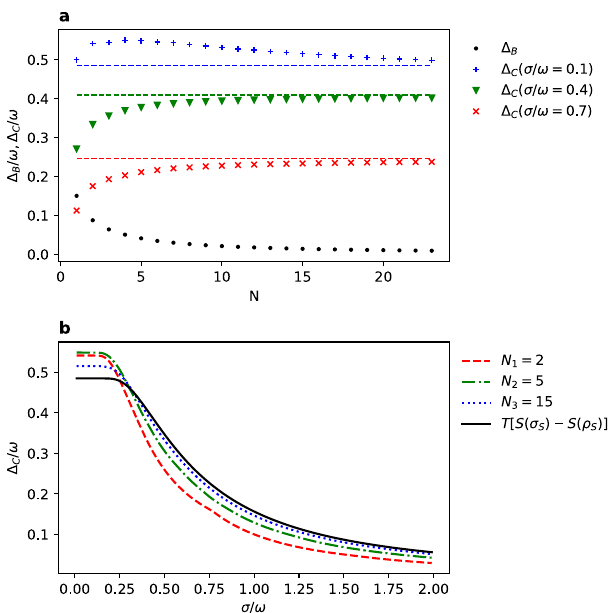
Fig. 1 Locked energy for a qubit in the state ^ ρ S ¼ þj i þh j S and with the energy gap ω . a Graph presents how the locked energy in a fi nite-size bath Δ ð ^ ρ ; ^ τ ð N Þ Þ and locked energy in coherences Δ B S B the number of qubits N in the heat bath (16), for different values of the scaled standard deviation σ / ω of the Gaussian state of the weight (17). Horizontal lines correspond to the thermodynamic limit ( N → ∞ ) of the locked energy in coherences expressed by the entropy difference: T ½ S ð ^ σ Þ (cid:2) S ð ^ ρ Þ(cid:3) . b The vanishing of the locked energy in coherences for S S a different size of the heat bath N with respect to the parameter σ / ω . The temperature of the bath is equal to T = 0.7 ω